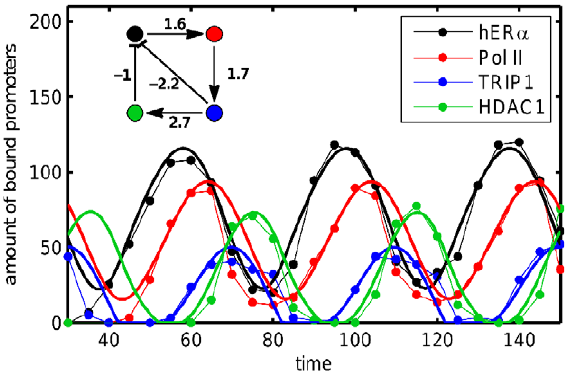
Figure 2. Adequacy of sequentially linear systems. Time series of periodic binding of four proteins to the pS2 promoter after addition of estradiol - experimental data has been extracted from [54], where a negative feedback-loop was proposed to explain the dynamics. Experimental data due to [25] and [26] (dotted lines) is compared with a simulation of a SL system, based on the network shown in the inset, with uniform decay rates D i ~ 1 : 08 for all agents and fixed point concentrations x (cid:2) ~ 75 ; 60 ; 20 ; 30 ½ (cid:3) . Correlation coefficients for simulat- ed and measured time-series are C i ~ (0 : 97 ; 0 : 84 ; 0 : 94 ; 0 : 97) for time larger 40 and agents i in order of the legend. The model simulation uses zero concentrations for all agents as initial condition and a time increment dt ~ 0 : 1 . For matching the simulation with experiment time in the model is shifted by { 40